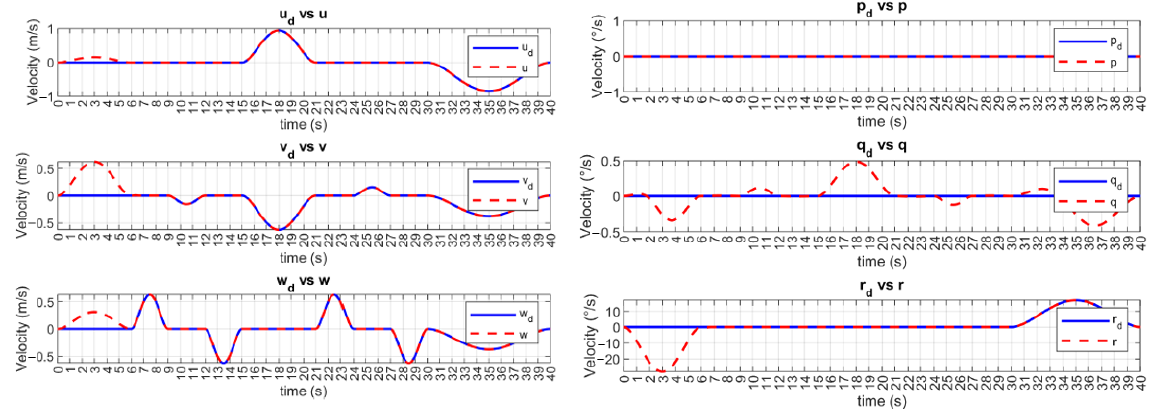
Right : BlueROV2 #2.